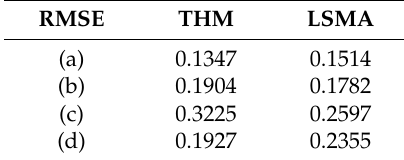
Table 3. Comparison of the RMSE of the four zones.